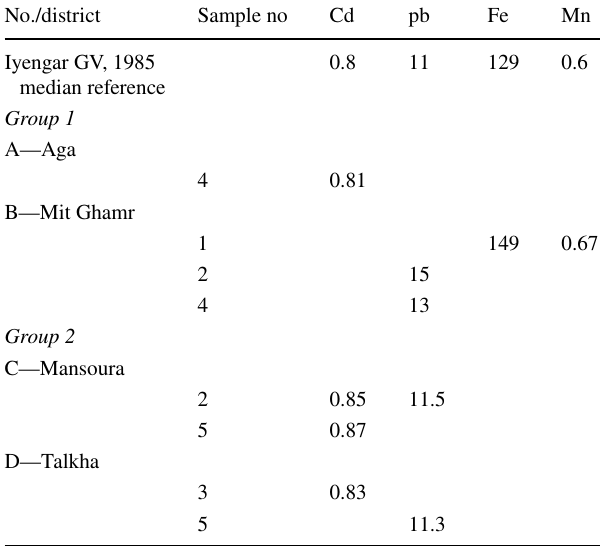
Table 3 High levels of heavy metals in urine samples